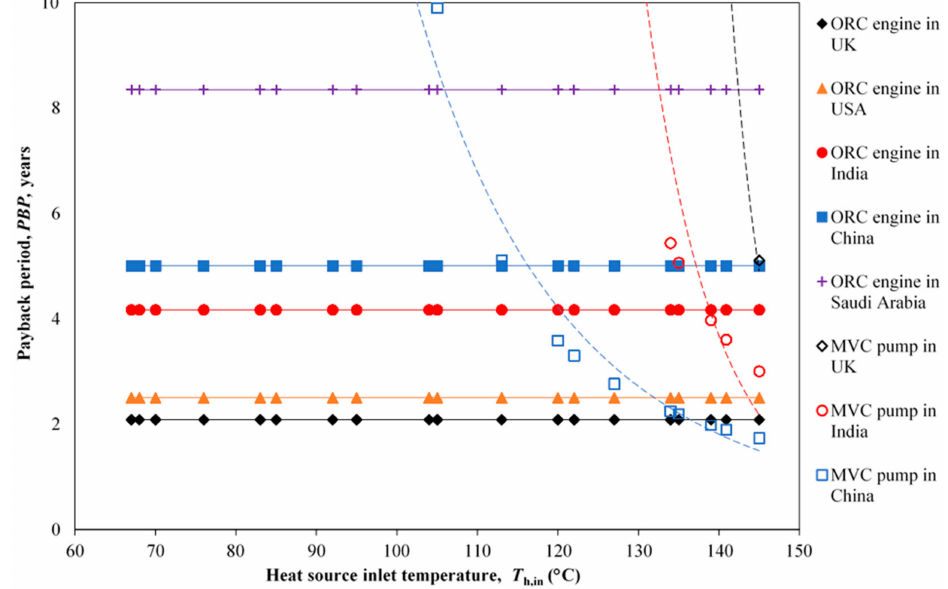
Figure 15. Payback periods associated with the use of ORC engines and MVC heat pumps in various countries as a function of the heat-source inlet temperature when utilizing the thermal energy available in the streams listed in Table 5. The heat sink is at 25 ◦ C for the ORC engines, and 150 ◦ C (LP steam) is produced for the MVC heat